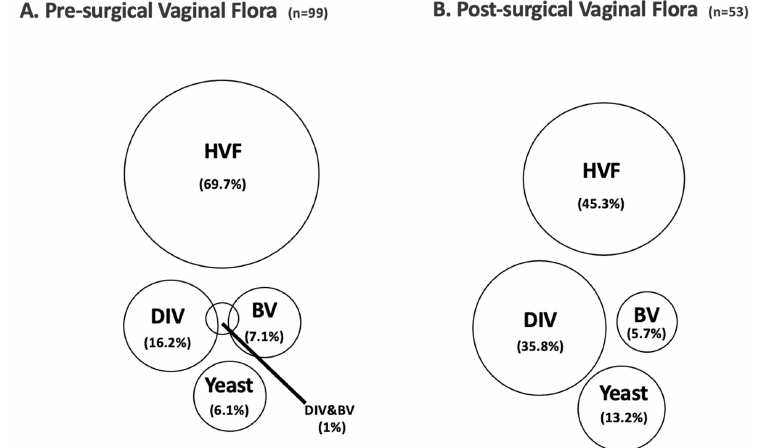
Figure 1. Results of vaginal swabs pre-surgical ( A ) and post-surgical ( B ); HVF—healthy vaginal flora, DIV—desquamative inflammatory vaginitis, BV—bacterial vaginosis.